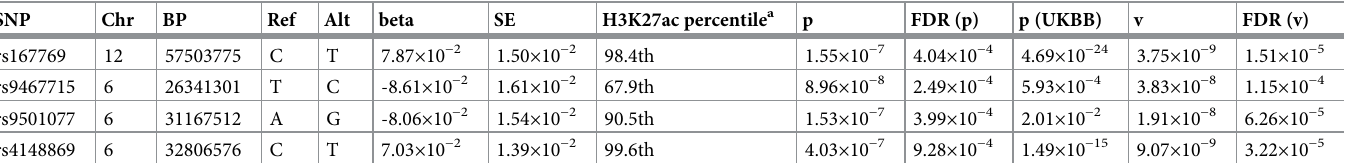
Table 4. Summary of newly significant asthma index SNPs when using Flexible cFDR to leverage H3K27ac data. Details of index SNPs that became newly FDR signifi- cant ( FDR < 0.000148249) after using Flexible cFDR to leverage H3K27ac fold change values with asthma GWAS p -values. Table contains the rsIDs (SNP), genomic posi- tions (Chr: chromosome, BP: base pair), reference (Ref) and alternative (Alt) alleles, log ORs (beta), standard errors (SE) and p -values from the discovery GWAS, mean H3K27ac fold change values across asthma relevant cell types, p -values from UK Biobank and resultant v -values from Flexible cFDR. For the original p -values (and v -val- ues), the corresponding FDR values are also given, calculated using the BH